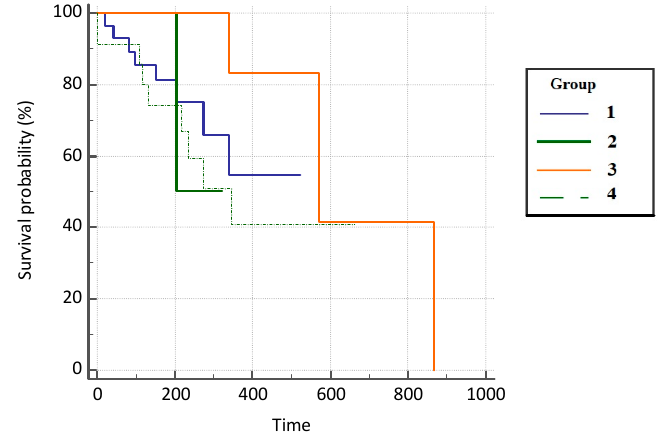
Figure 4. Progression-free survival (PFS) in analyzed groups of patients . Table 3. Hazard ratios (HR) with 95% confidence interval for PFS.